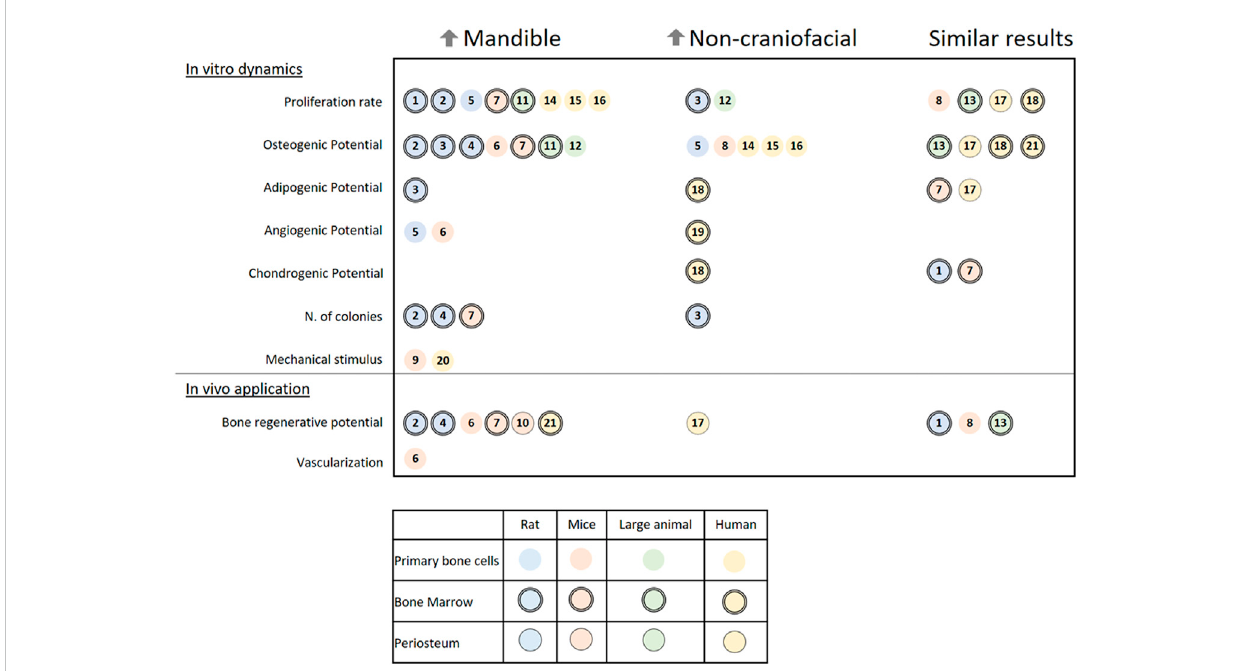
FIGURE 5 A literature review on the in vitro dynamics and in vivo applications of different cells harvested from the mandible and non-craniofacial bones. The results are separated into three columns referencing papers (a totalof 21 papers) inwhichcells from the mandible of rats, mice, large animals,or humans presented higher activity ( ↑ Mandible) or lower activity ( ↑ Non-craniofacial) or similar activity (Similar results) whenharvested from thesame individual and compared in the same conditions to non-craniofacial bones cells. Symbols indicate the origin of the cells: Rats (blue), mice (rosa), large animal models(green),humans(yellow),primarybonecells(opencircle),bonemarrowcells(doublecontouredcircle),andperiosteum(singlecontouredcircle). Numbered references: 1) 10.1177/2041731419830427, 2) 10.1007/s00441-014-1927-4, 3) 10.1089/scd.2019.0256, 4) 10.1177/0022034510378427, 5) 10.1007/s10735-019-09810-6, 6) 10.1016/j.jbo.2020.100346, 7) 10.1177/0022034510387796, 8) 10.1002/jbm4.10382, 9)